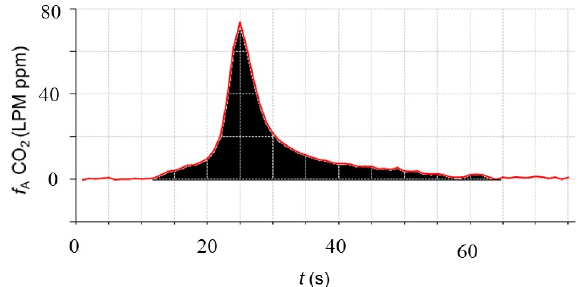
Figure 2. Example output from the CO 2 detector in the TCA08 Total Carbon Analyzer, showing the combustion-derived pulse of CO 2 superimposed on the ambient-air